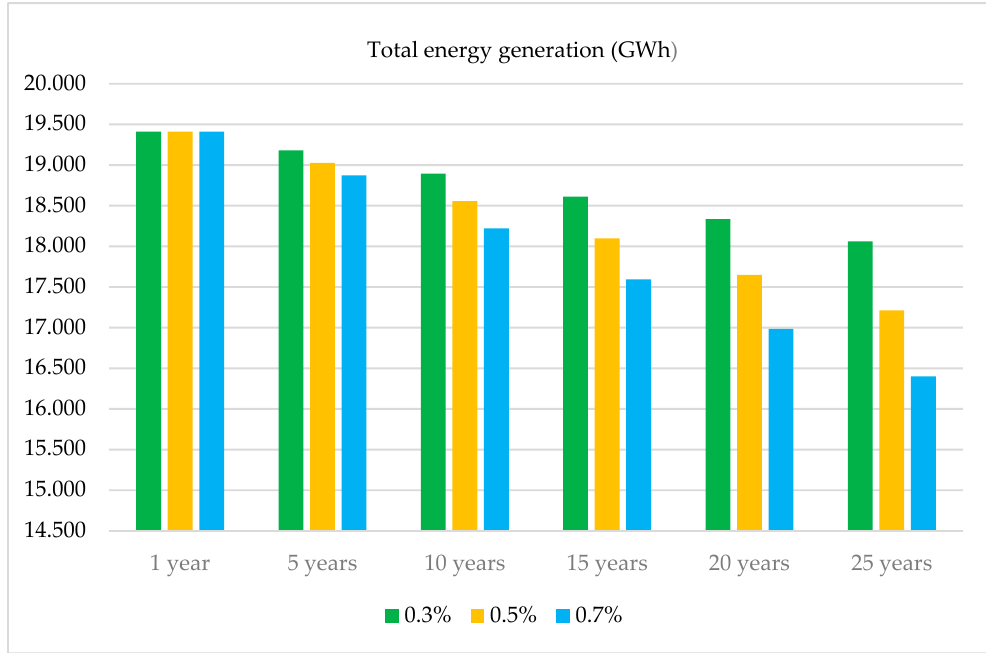
Figure 14. Total energy for reduction coefficient variations.